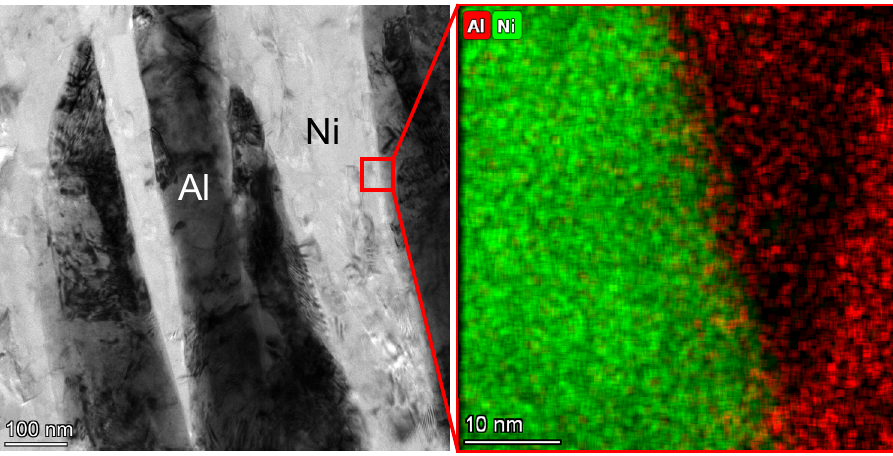
Figure 5. XRD results of the Al/Ni energetic composites. Figure 6. DSC curves of the Al/Ni energetic composites.